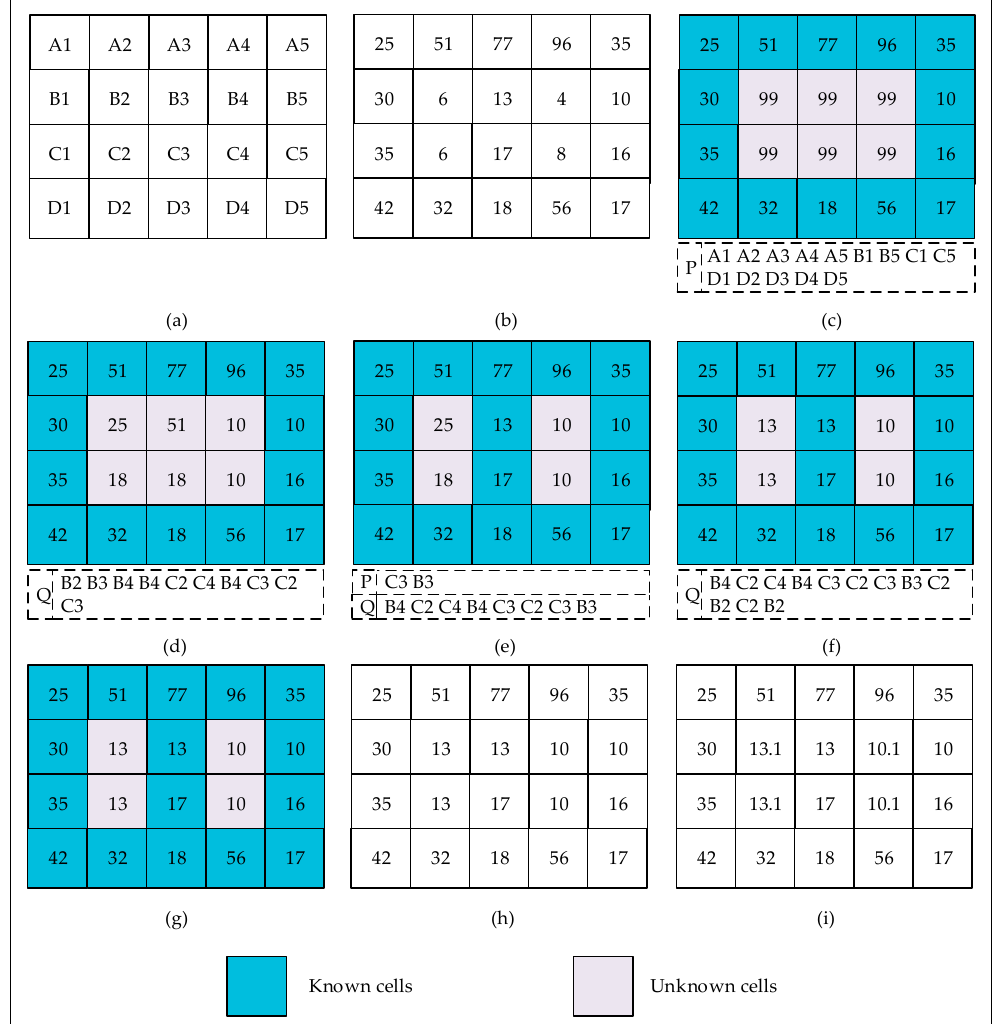
Figure 3. A two-dimensional example of our variant. ( a ) A sample DEM with labeled cells. ( b ) DEM with elevation values. ( c ) All non-border cells of the DEM are inundated with a thick layer of water. All border cells of the DEM are regarded as known cells and pushed into P. ( d – f ) Cells of the P and Q are used as seed cell for the RGP. Many cells become unknown cells and are pushed into Q during the process. ( g ) P and Q are empty, and our variant ends. ( h ) Depressions in the DEM are filled with strictly horizontal surfaces. ( i ) Depressions in the DEM are filled with slightly sloping surfaces.